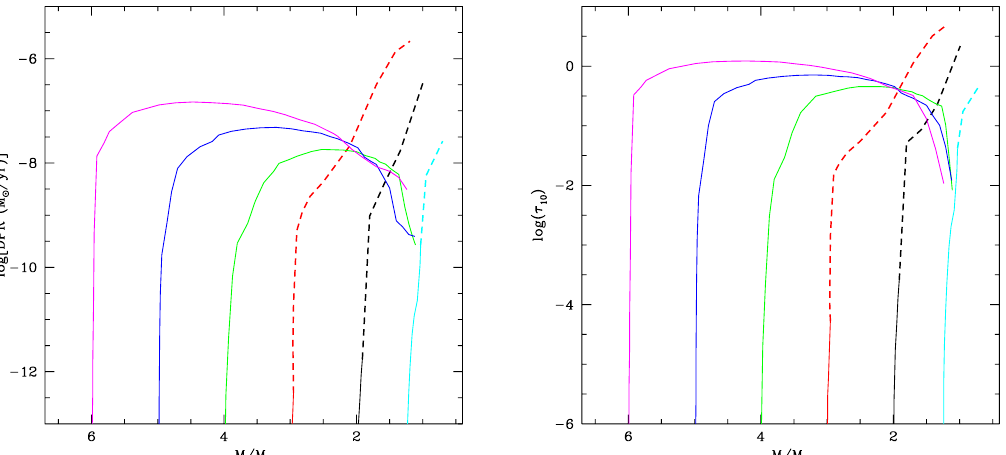
Figure 1. Evolution of the dust production rate (left) and optical depth at 10 µ m (right) during the AGB phase of stars of initial mass 1.25 M (cid:12) (cyan), 2 M (cid:12) (black), 3 M (cid:12) (red), 4 M (cid:12) (green), 5 M (cid:12) (blue), 6 M (cid:12) (magenta). In the abscissa we show the current mass of the star. The dashed parts of the tracks refer to the phases during which the star is carbon rich. The evolutionary sequences shown are the same used by